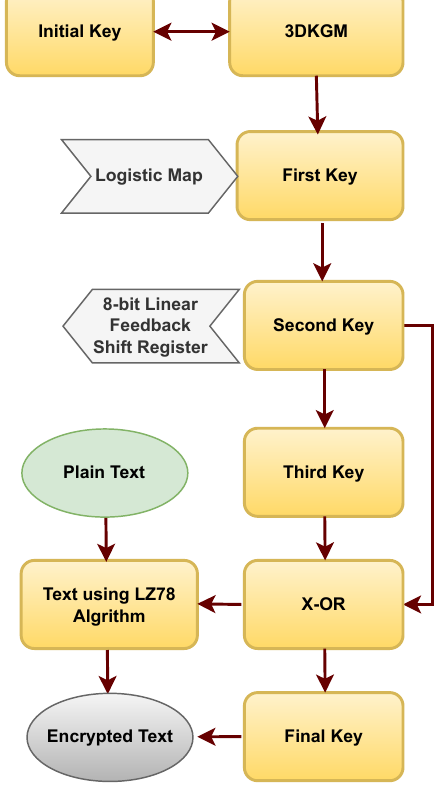
Figure 4. Proposed Key Generating